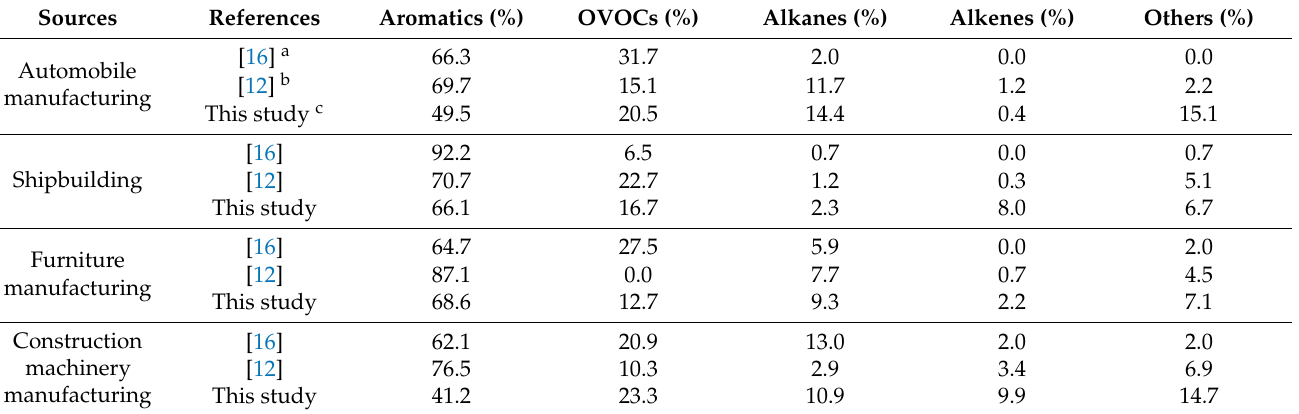
Table 3. VOCs chemical compositions of industrial coating sources and their comparison with other